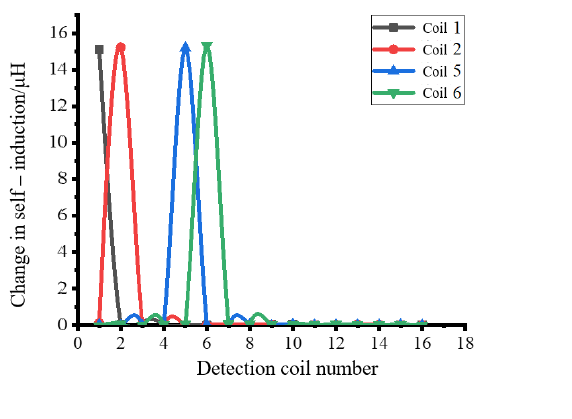
Figure 7. The self-inductance change of the detection coil. ( a ) Self-inductance curve under the copper sheet. ( b ) Self-inductance curve under the steel sheet.